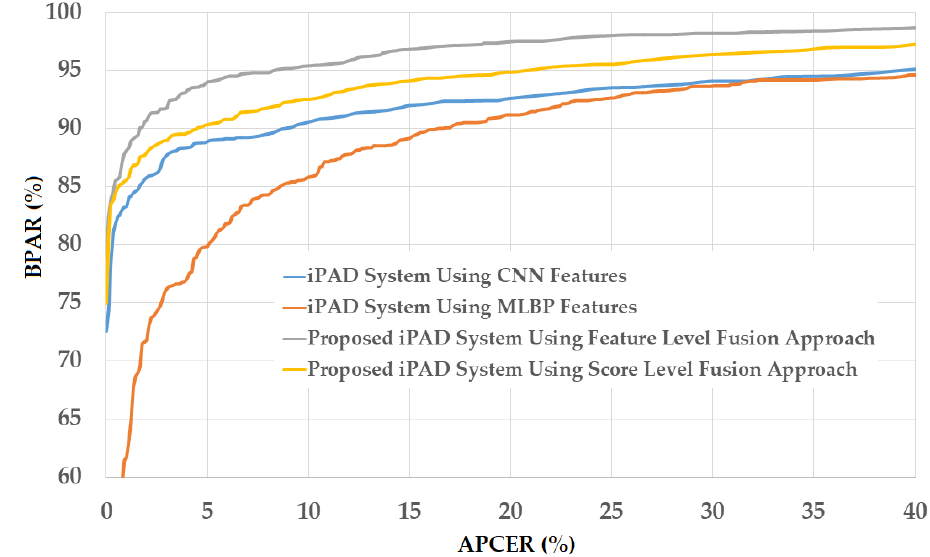
Figure 15. DET curves of iPAD systems based on use of CNN, MLBP, and hybrid image features (feature level fusion and score level fusion approach) using the second division method and ND2015 test-unknown dataset.